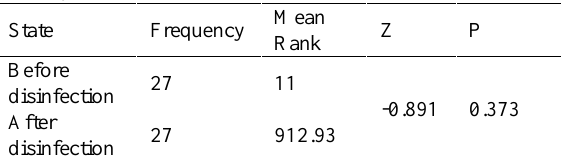
Table 4. Colony count before and after disinfection in hospital B (T-Test) State